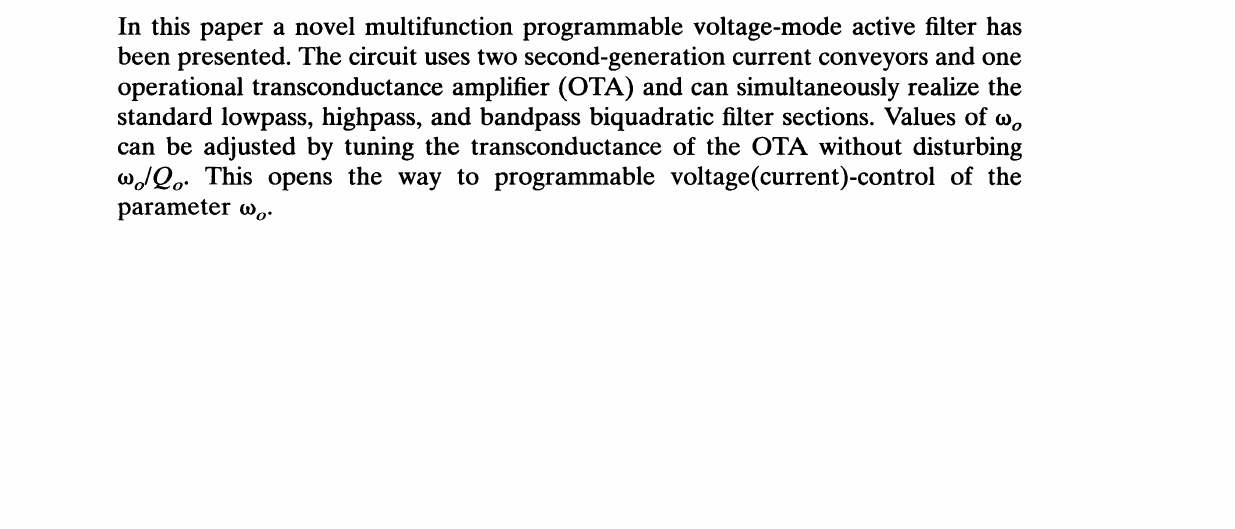
with Rmp., 5MfI,Routpu, lOMfI,Co,tpu, ipF, gm lmA/V. The results